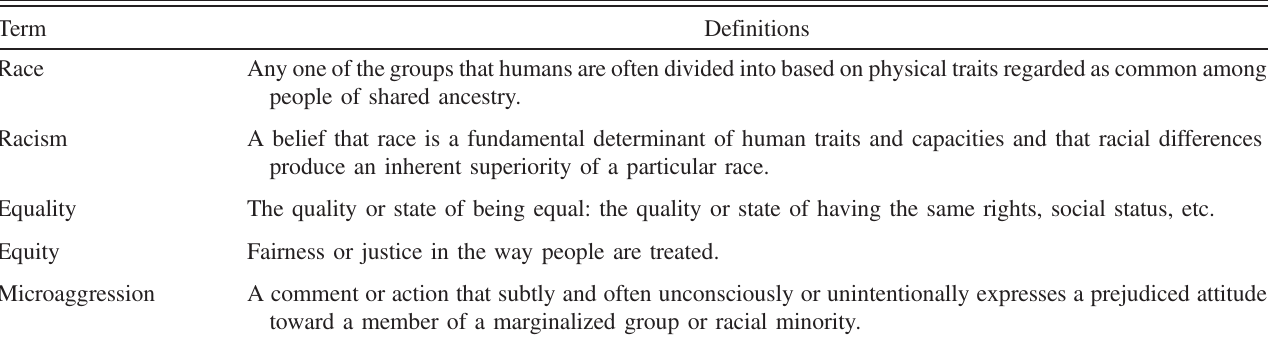
TABLE I. Common terms and basic definitions taken from the Webster-Merriam dictionary. We will expand on some of them further in the